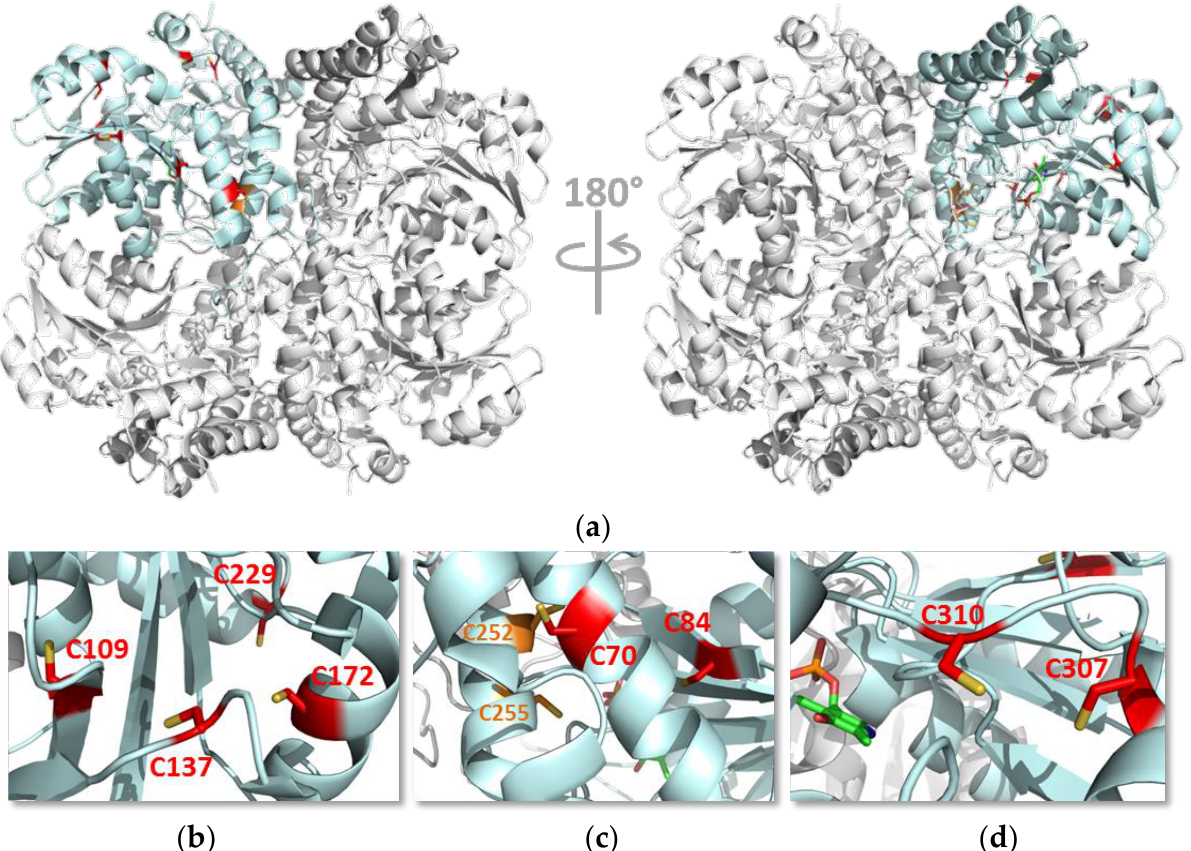
Figure 7. Structure of human cystathionine γ -lyase. ( a ) Cartoon representation of the crystallographic structure of human CSE (PDB ID: 2NMP). One monomer is colored in light blue, while the remaining monomers are shown in grey. ( b – d ) Zoom- in on the regions of the protein where the cysteine residues investigated in this study are located. Red sticks, Cys residues that have been shown to be S -nitrosated; orange sticks, Cys residues without evidence for S -nitrosation; green sticks, PLP moiety in the active